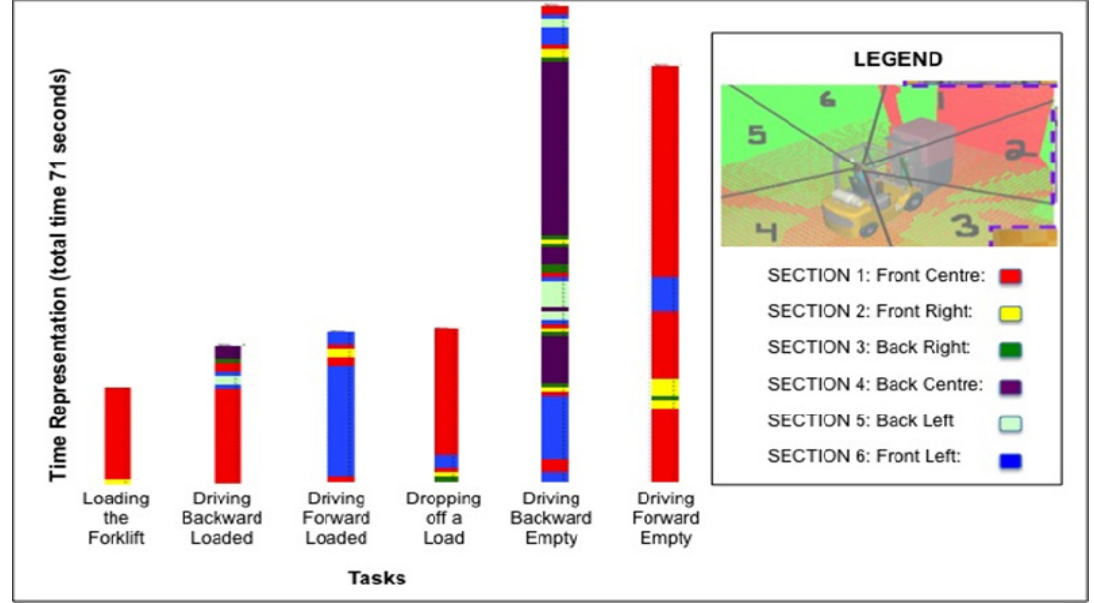
Figure 3. Representation of the time spent looking to one of six sections (see legend) while loading the forklift, driving loaded, dropping off a load and driving empty for one loading and unloading cycle. The color scheme represents the different sections during the tasks (see legend), and the height of the bars represents the amount of time spent. The total time to complete the load/drive/unload cycle was 71